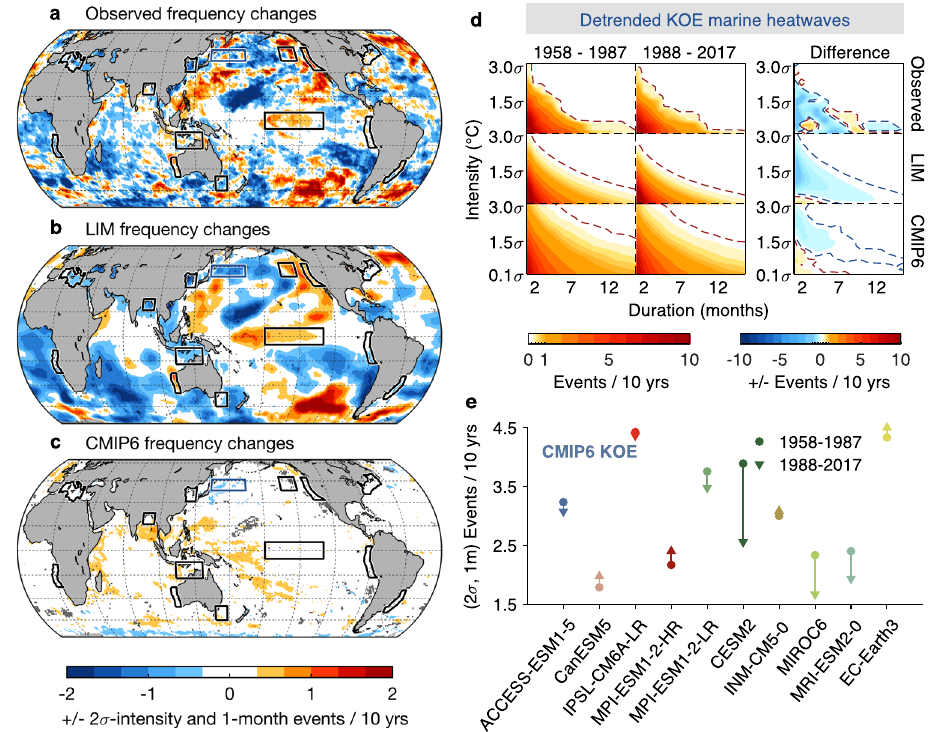
Fig. 6 | Impact of changes in the internal (detrended) variability on Marine Heatwave (MHW) occurrences. a – c Same as Fig. 5c – e except that MHWs are derived from detrended dataset: a observed detrended Sea Surface Temperature Anomaly(SSTA), b LIM5887andLIM8817,and c detrendedCMIP6. d SameasFig.5b